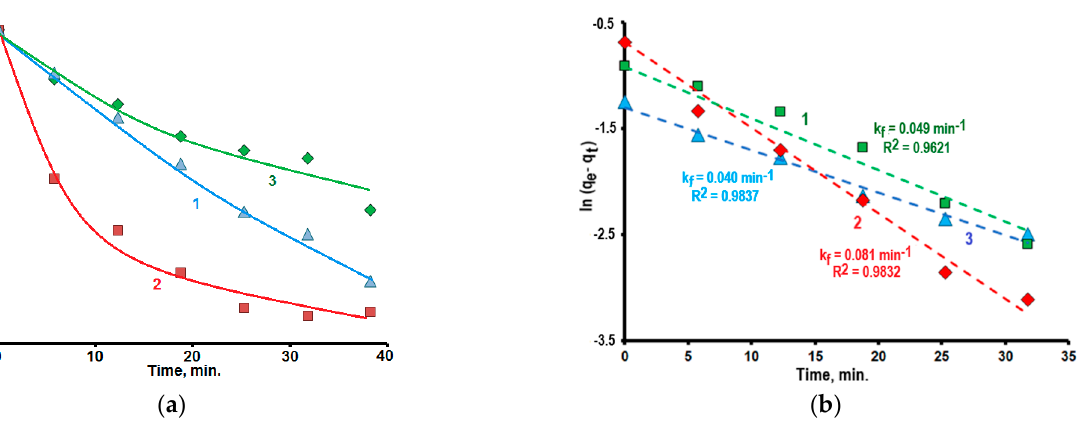
Figure 6. ( a ) Kinetic dependencies of the dye adsorption from solutions on surfaces of powder sam ‐ ples 2 (curve 1), 3 (curve 2), 4 (curve 3). ( b ) Dependencies ln(q e − q t ) = f(t ) which were obtained from experimental data for the dye adsorption on the surfaces of powder samples 2 (curve 1), 3 (curve 2), 4 (curve